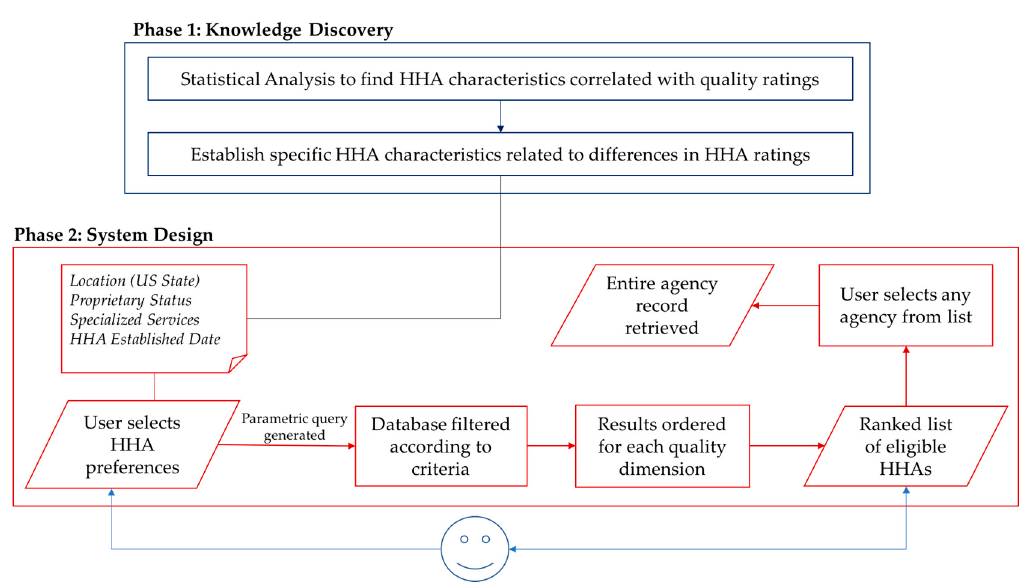
Figure 1. With the knowledge discovery phase, we found relationships of home health agency (HHA) variables with quality ratings, serving as the evidence base for the system design.